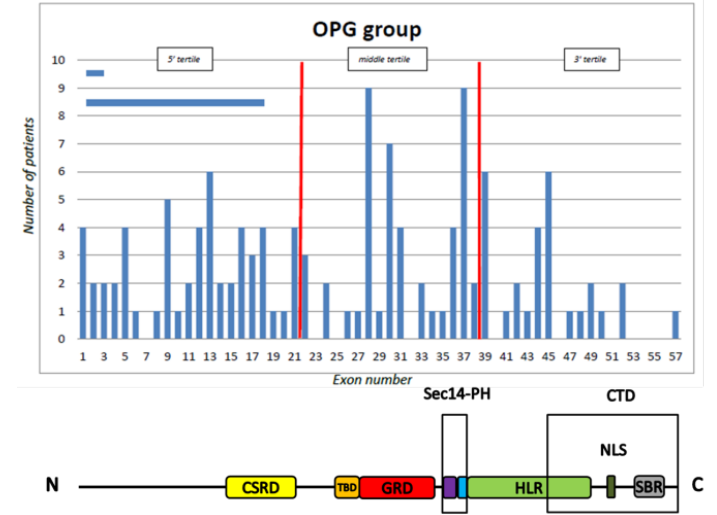
Figure 2. Distribution of NFI gene mutations by tertile and domain in the optic pathway glioma (OPG) group. The horizontal bars indicate two OPG patients with a large deletion involving more than one exon. The vertical red lines indicate the limits of the tertiles.